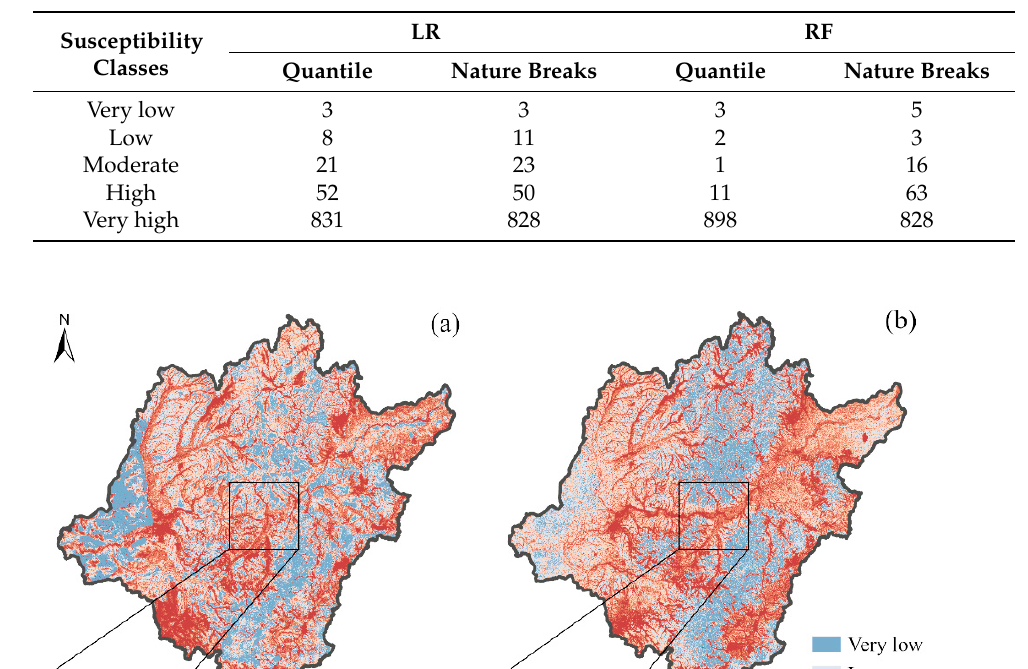
Figure 10. FFSM pixels located in various susceptibility classes for the two different models.